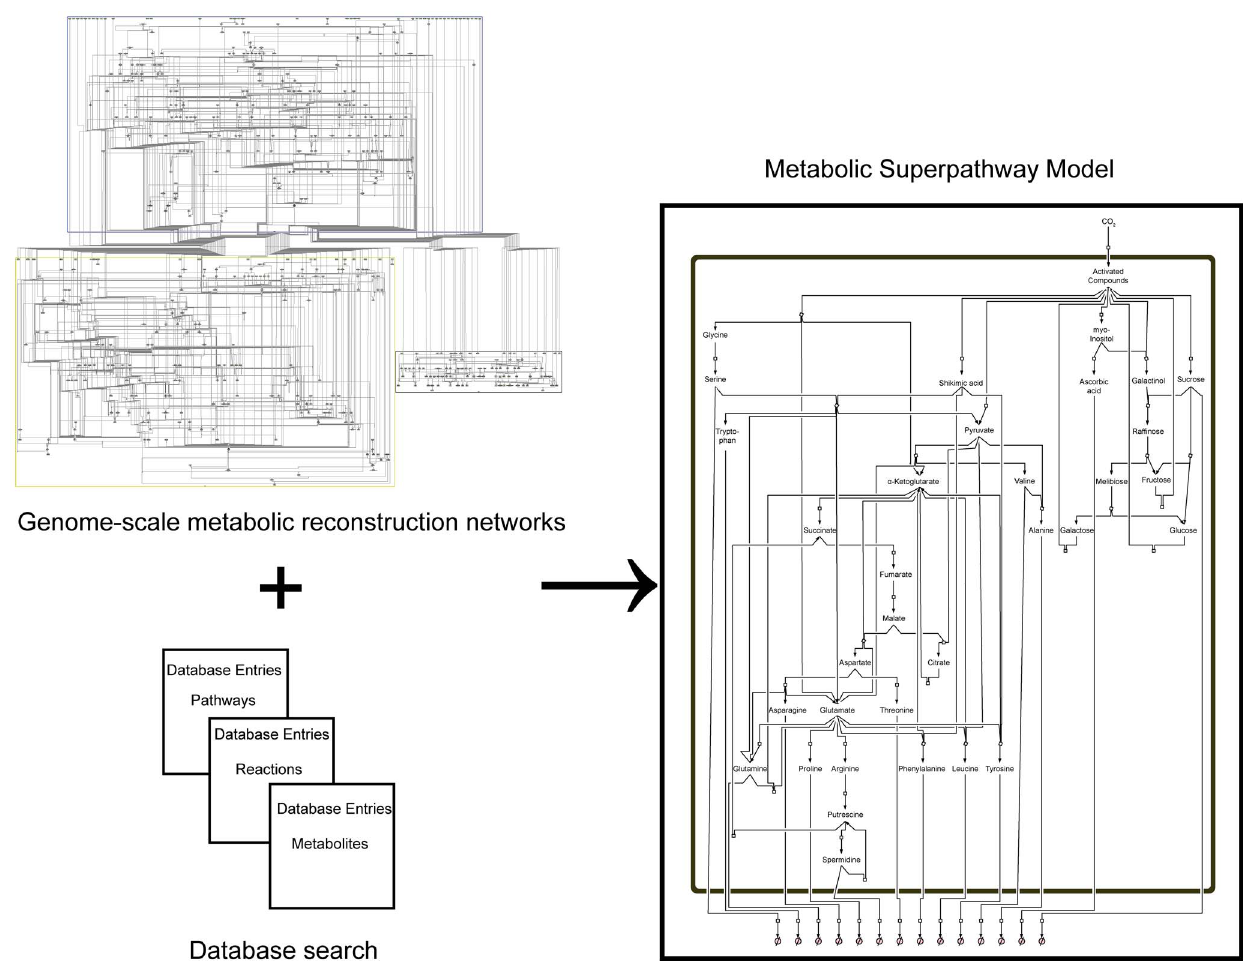
Figure 1. Development of a superpathway model for primary leaf metabolism. The model structure was derived from stoichiometric and biochemical information provided by genome-scale metabolic networks and databases. The model is provided in SBML format in the supplements (Model S1).